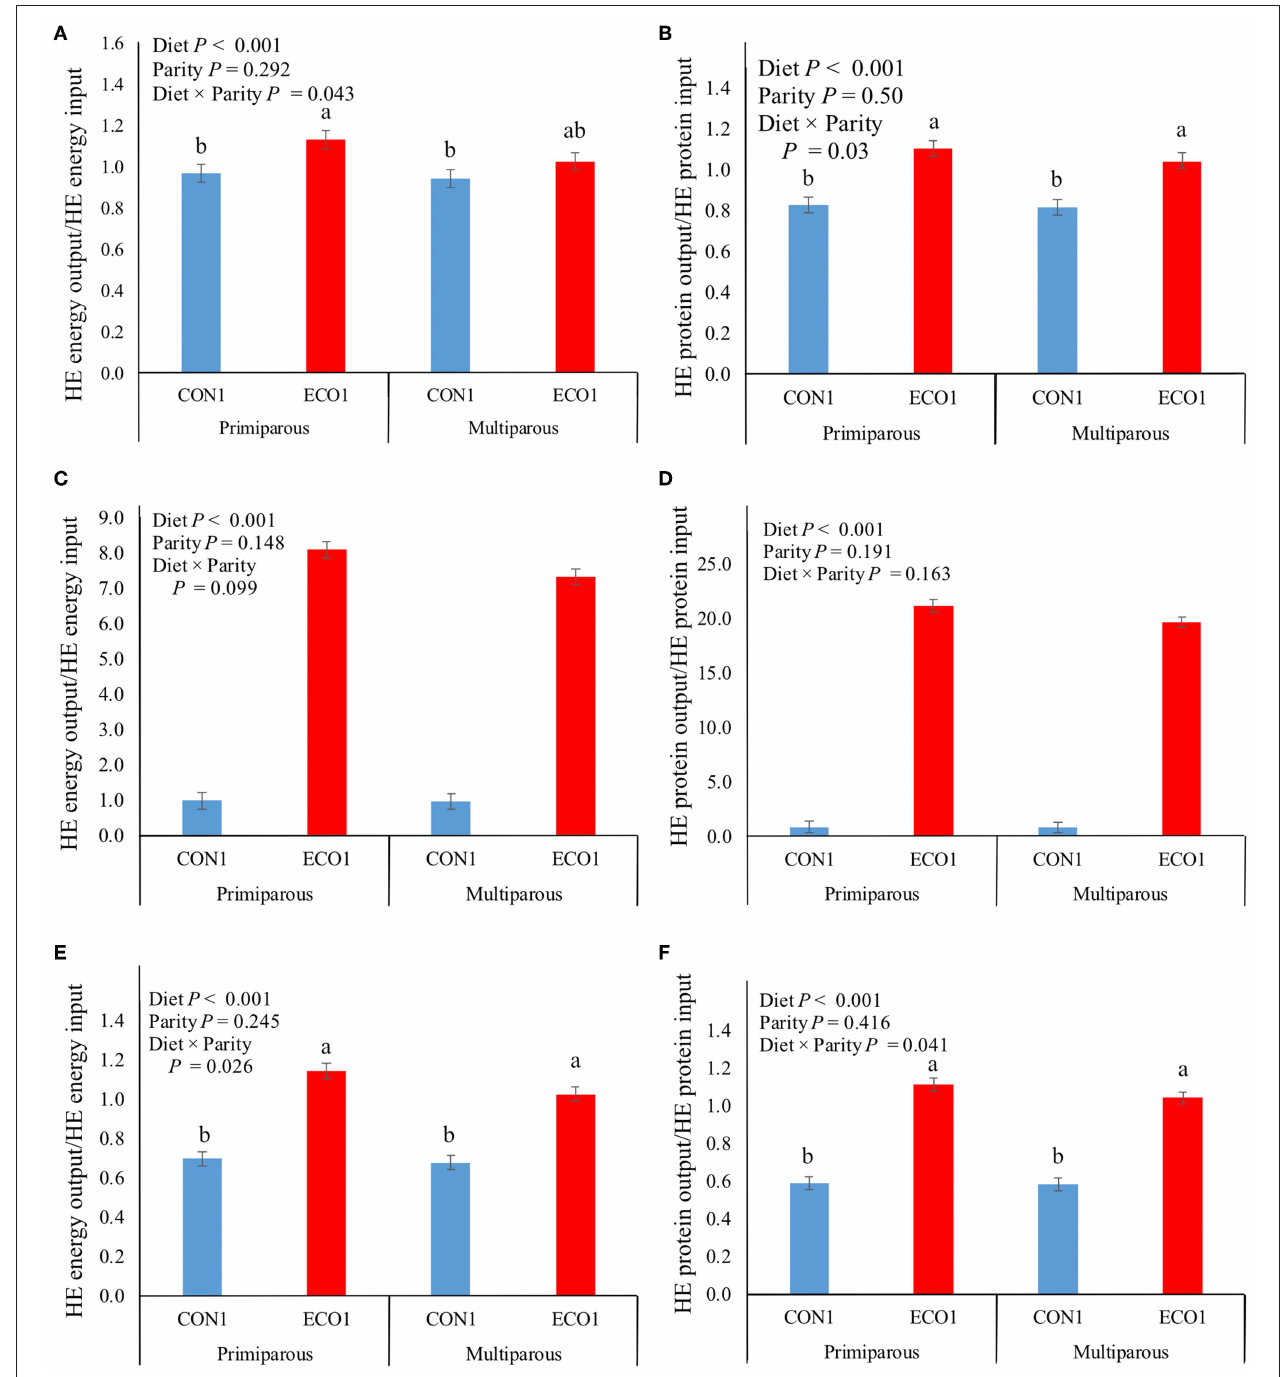
FIGURE 1 | Human-edible (HE) metabolizable energy (left panels) and protein (right panels) conversion rate of mid-lactation cows fed a conventional lactation diet or a co-product-based diet (Experiment 1) in a thrift scenario (A,B) , a choice scenario (C,D) , or a land use scenario (E,F) . A recovery value of 2 would indicate that for every HE unit (either MJ or protein) the cow consumes, she would produce 2 HE unit in milk. Thrift scenario considered that hominy feed and wheat middlings were edible by humans, whereas choice scenario considered that hominy feed and wheat middlings were not edible by humans. Land use scenario calculations were made based on thrift scenario with additional consideration that the land used for alfalfa production could have been used to grow corn and soybeans for direct human consumption. Treatments: conventional lactation TMR (CON1), containing 31% by-product feeds; and TMR composed of ecological leftover feedstuff (ECO1), containing 95% by-product feeds. Letters above columns describe treatment by parity differences ( P < 0.05; Tukey’s Honestly Significant Difference test). Error bars are SE.